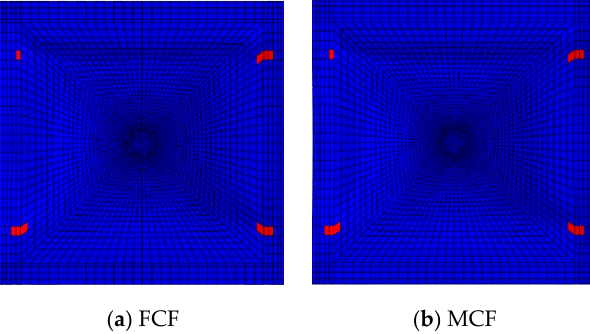
Figure 21. Failure modes of outer skin in the CD40 Model. ( a ) Fiber compressive failure (FCF); ( b ) Matrix compressive failure (MCF).